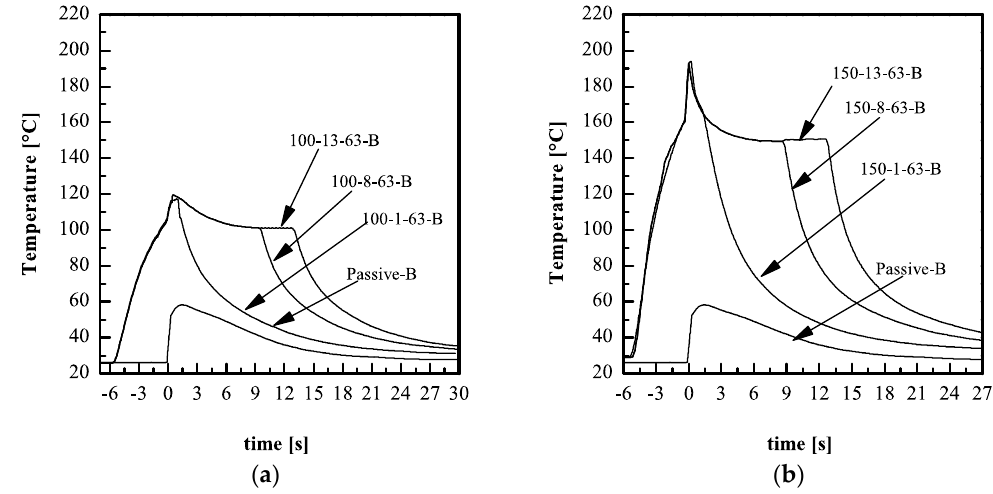
Figure 1. Temperature evolutions recorded during the experiments performed on PLA4032D ( a ) with T level = 100 °C, and ( b ) T level = 150 °C; the temperature evolution of the test Passive-B is also reported for comparison.